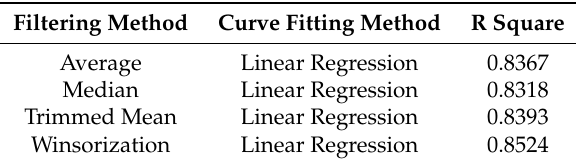
Table 3. RSSI to distance hall band 2.